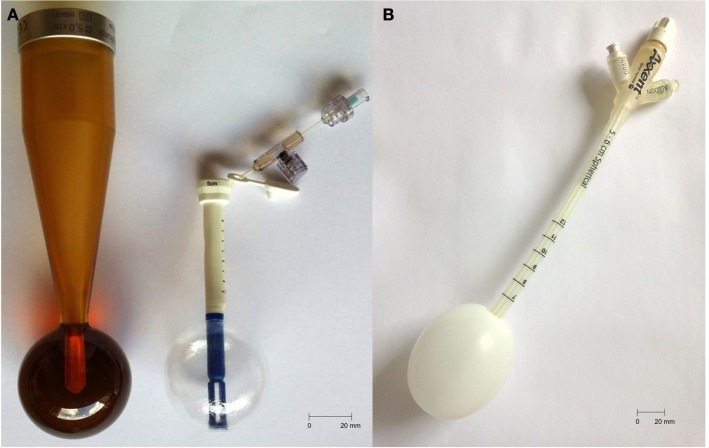
(A) Intrabeam: 50 mm rigid (left) and balloon (right) applicators, stalk length = 135 and 65 mm, respectively; (B) Xoft: 50–60 mm applicator, stalk length = 250 mm.